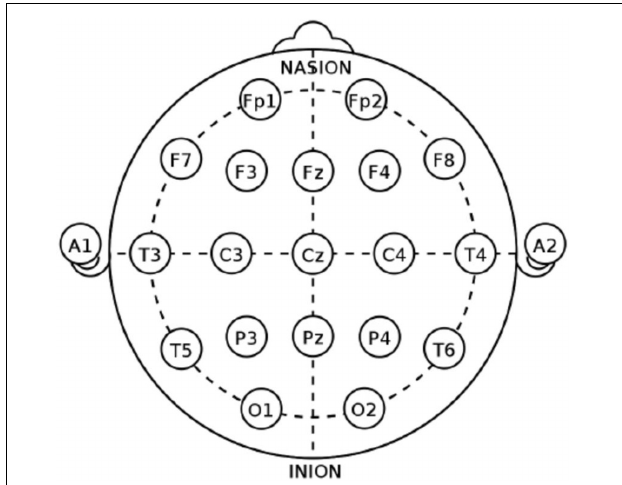
FIGURE 2 | The 10–20 international system of EEG electrodes